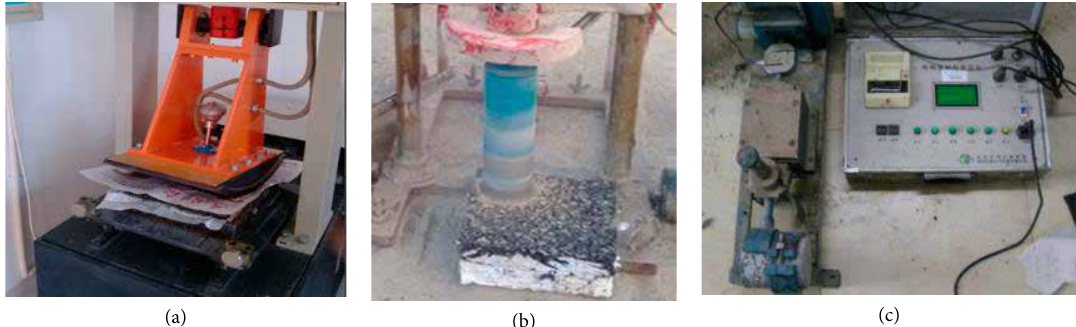
Figure 11: Interlayer shear test: (a) formed double-layer rutting plate, (b) core drilling sampling, (c) shear